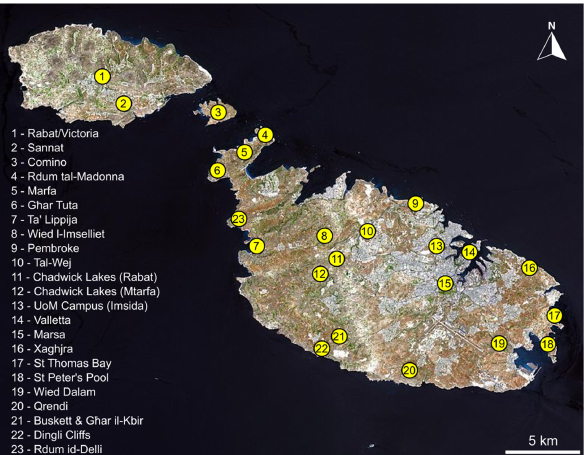
Figure 1. Map showing location of sampling sites for intranidal myrmecophiles across the Maltese Islands.